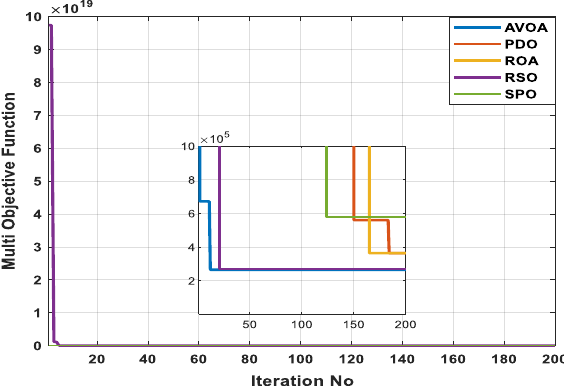
Figure 20. The AVOA convergence characteristics with the other compared methods for case 9.